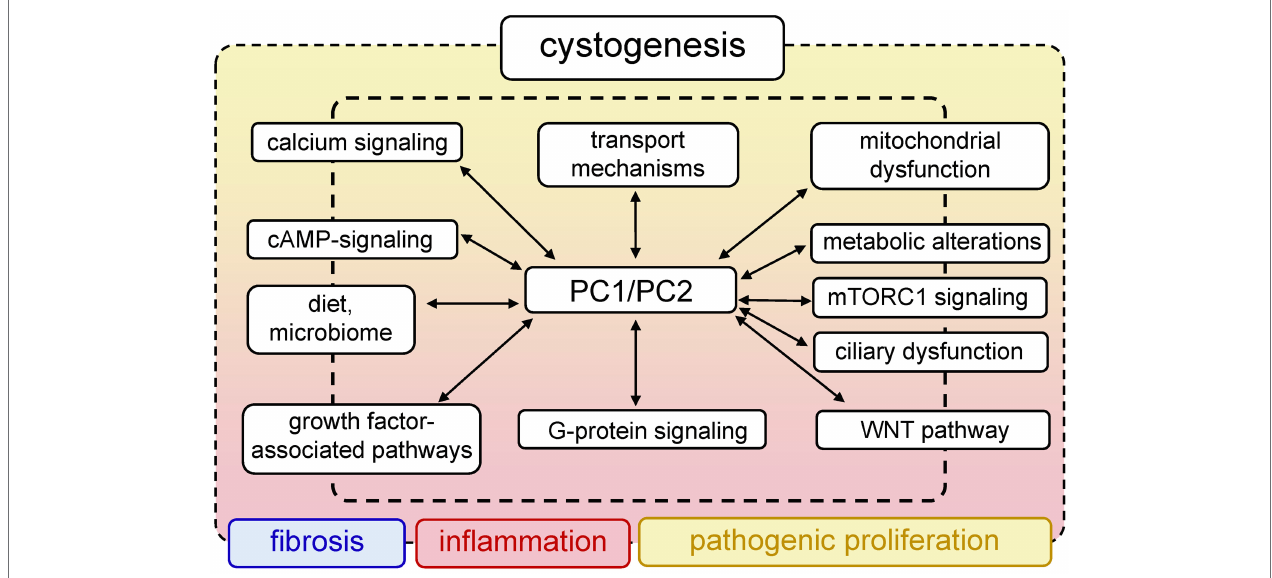
FIGURE 1 | Generalized pathways involved in PKD development. Mutations in PKD1/PKD2 lead to aberrant functionality of a variety of interconnected signaling pathways, which can result in abnormal proliferation, fibrosis, and inflammation that accompany